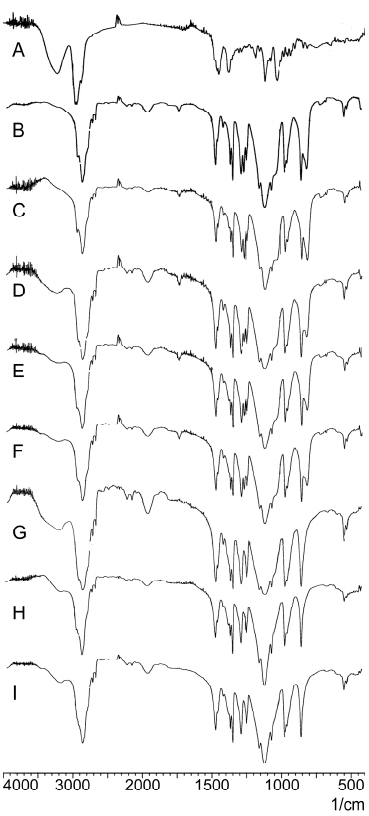
Figure 4. Fourier transform infrared spectroscopy (FTIR) spectra of PPD ( A ), PEG6000 ( B ), F68 ( C ), F1 ( D ), F2 ( E ), F3 ( F ), PEG6000 PM ( G ), F68 PM ( H ), PEG6000 and F68 PM ( I ).